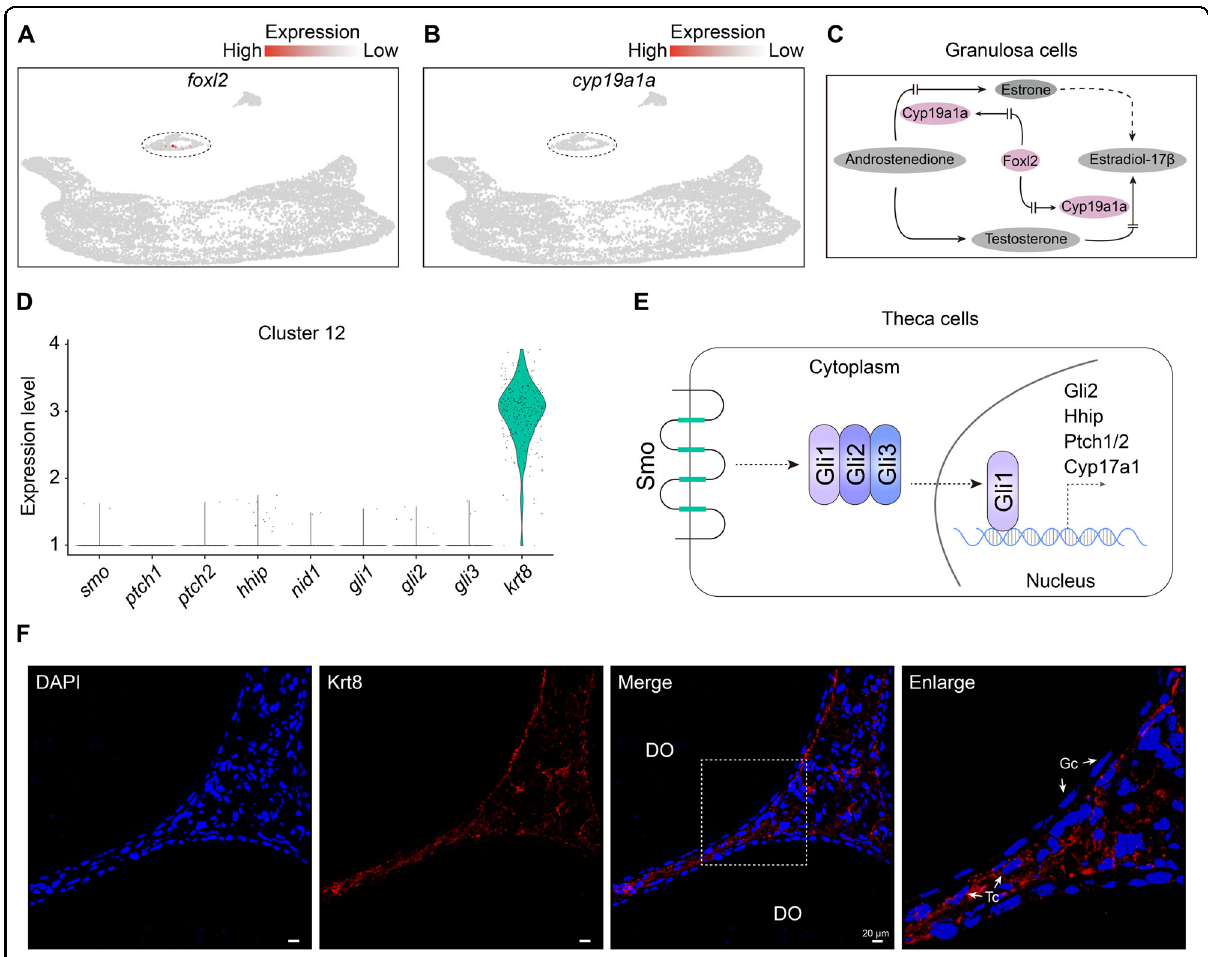
Fig. 3 Loss of signaling pathways in the niche cells of ovary. A UMAP maps indicating scarce expression of foxl2 in cluster 11. B Scarce expression of cyp19a1a in clusters 11. C Foxl2-Cyp19a1a pathway in female steroid biosynthesis process. D Relative expressions of hedgehog signaling pathway genes ( ptch1/2, smo, hhip, gli1 , gli2 , and gli3 ), nid1 (a gene encoding basal lamina-speci fi c adhesive protein), and krt8 . E Diagram indicating hedgehog signaling pathway in the theca cells. F Immuno fl uorescence analysis using Krt8 antibody in ovotestis (second antibody, TRITC-conjugated ImmunoPure goat anti-rabbit IgG (H + L)). The nuclei are stained with DAPI. Positive signals are located in Theca cells (arrows). The enlarged images on the right panel originated from the dotted line square on the left panel. DO degrading oocyte, Gc Granulosa cells, Tc Theca cells. Scale bar: 20